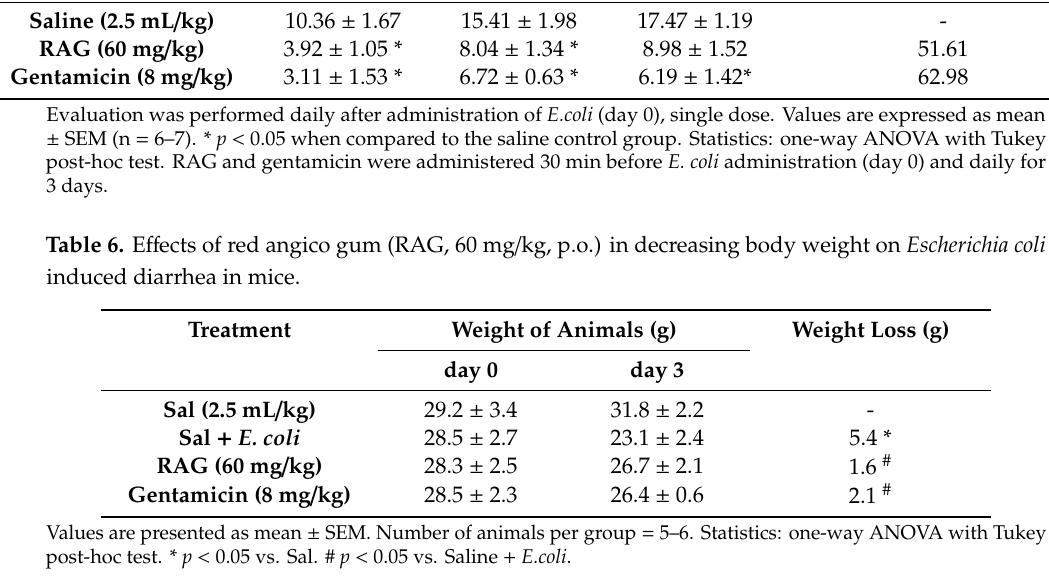
Table 5. E ff ects of red angico gum (RAG, 60 mg / kg, p.o.) on Escherichia coli -induced diarrhea in mice. Treatment Total Amount of Diarrheal Stool (g) Table 6. Effects of red angico gum (RAG, 60 mg / kg, p.o.) in decreasing body weight on Escherichia coli induced diarrhea in mice.